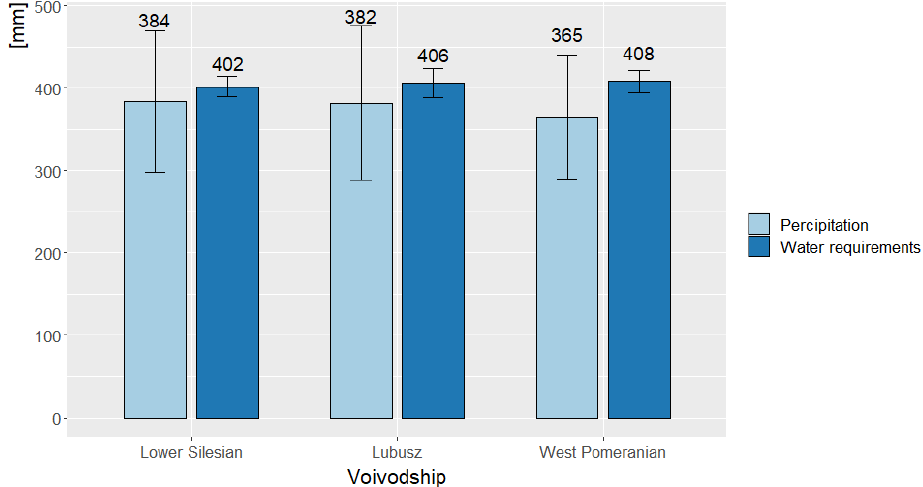
Figure 8. Water needs of willow and average precipitation during the growing season for individual provinces in 1981–2010. provinces in